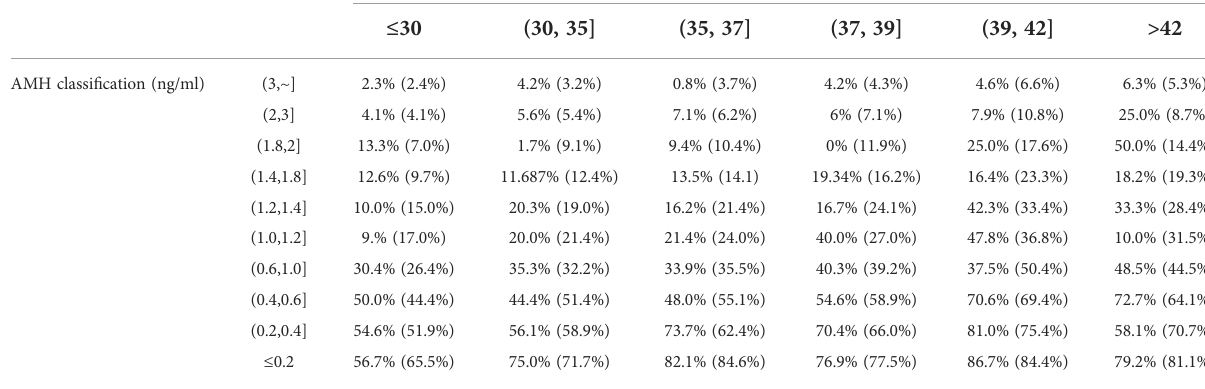
TABLE 3 The actual incidence (predicted probability) of POR.